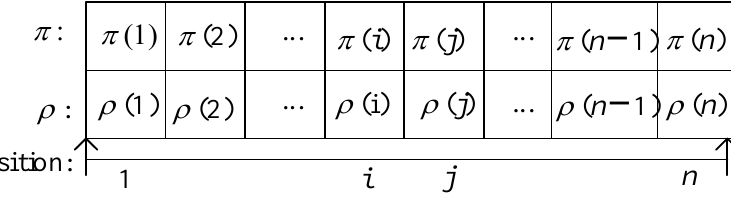
Figure 2. The schematic diagram of the individual encoding structure.